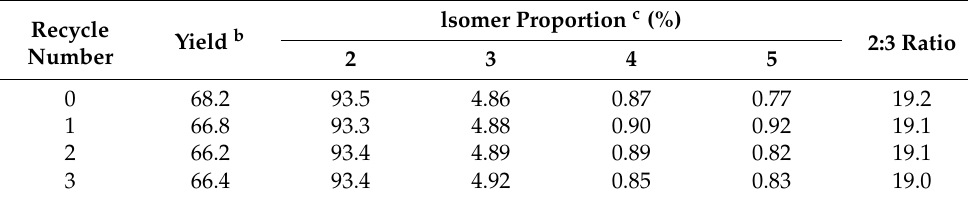
Table 6. Efficiency of recycled HBEA-25 in the preparation of nitro- naphthalene a .